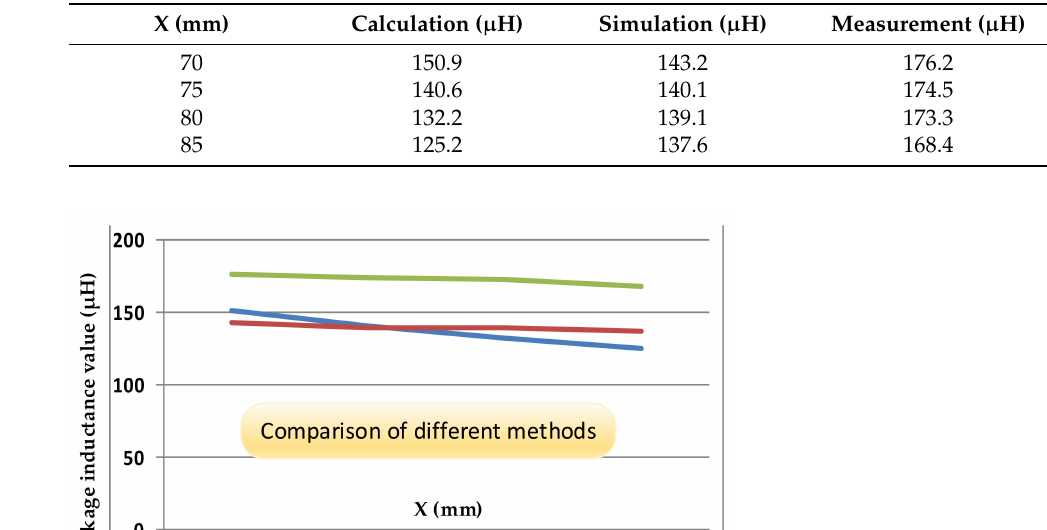
Figure 9. Magnetic field intensity distributions with ( a ) X = 70 mm ( b ) X = 85 mm. Table 4. Transformer leakage inductance with variation in parameter X.